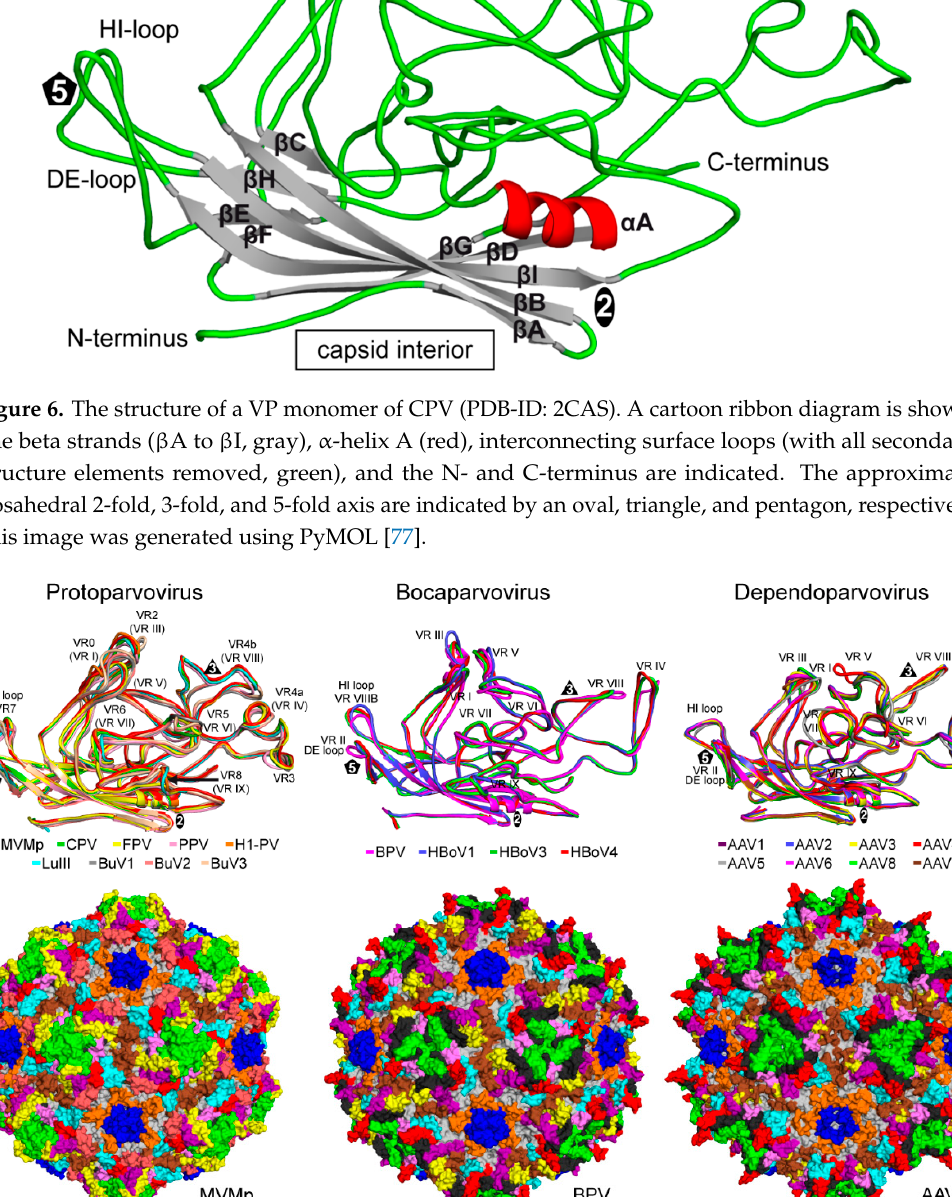
Figure 7. The VRs of the Parvovirinae . ( A ) Structural superposition of VP monomers from different members of Protoparvovirus (left), Bocaparvovirus (center), and Dependoparvovirus . Individual colors for the ribbons are as indicated. The VRs: VR ‐ I to VR ‐ IX (or VR0 to VR8 for the protoparvoviruses), the DE, and HI loops are shown. ( B ) Location of the VRs, colored as indicated, on the capsid surface of MVMp as an example for Protoparvovirus (left), BPV for Bocaparvovirus (center), and AAV2 for Dependoparvovirus (right). The figures were generated using PyMOL [77].